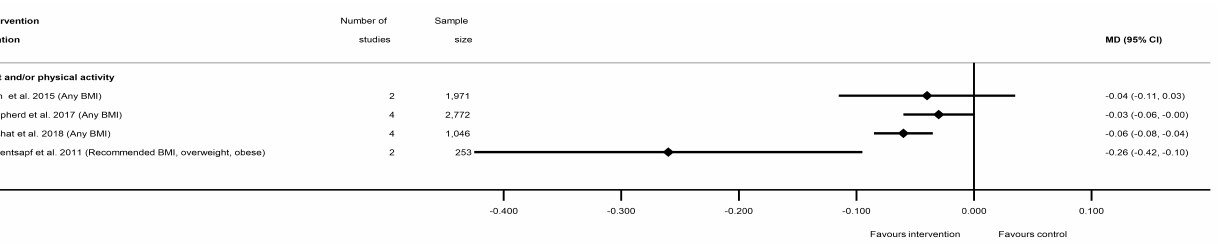
Figure 2. Forest plot of meta-analysis results for total gestational weight gain (GWG).